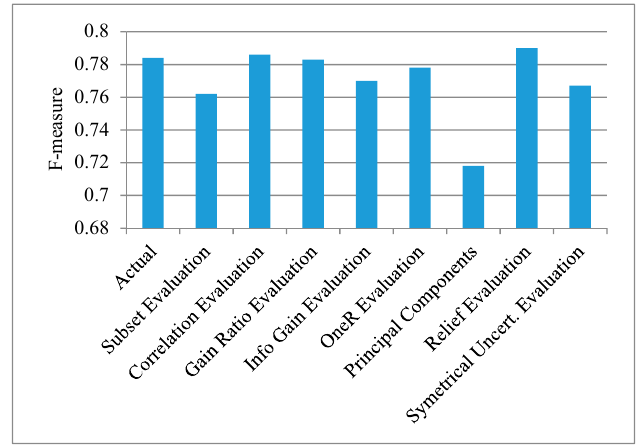
Figure 2. SVM performance based on the F-measure for the Actual 1024 attributes and the F-measure based on the attributes selected by the corresponding algorithm.